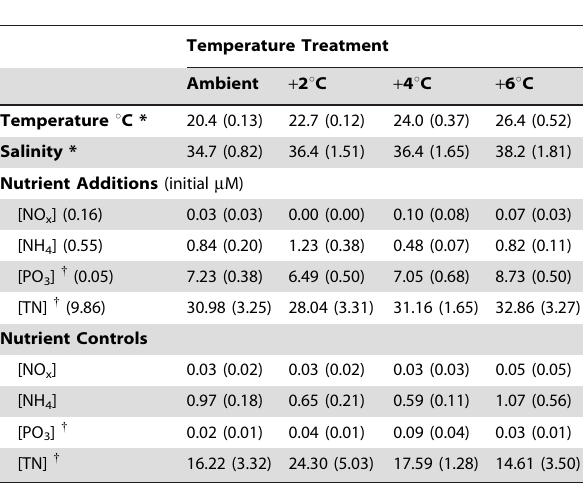
Table 1. Experimental temperature and nutrient treatments.